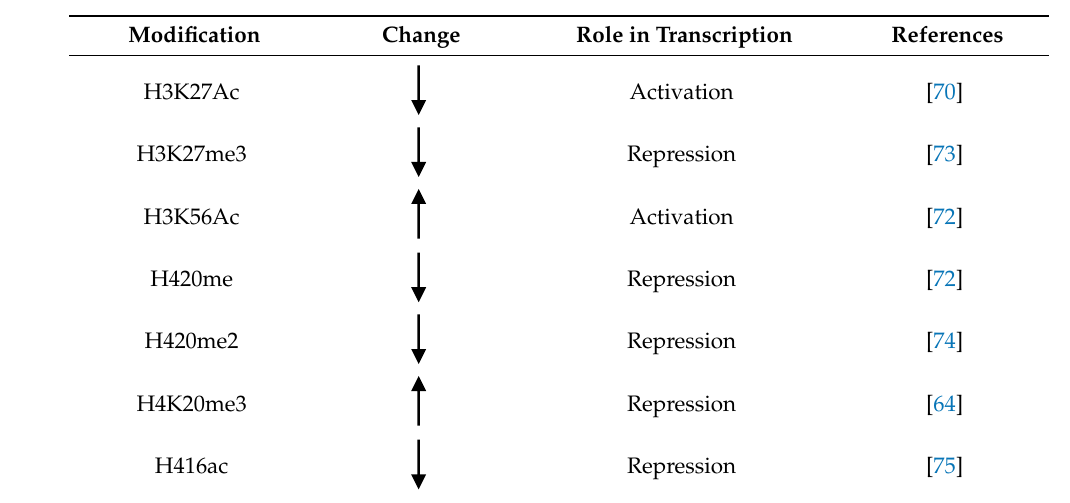
Table 1. Histone modification patterns in association with aging.